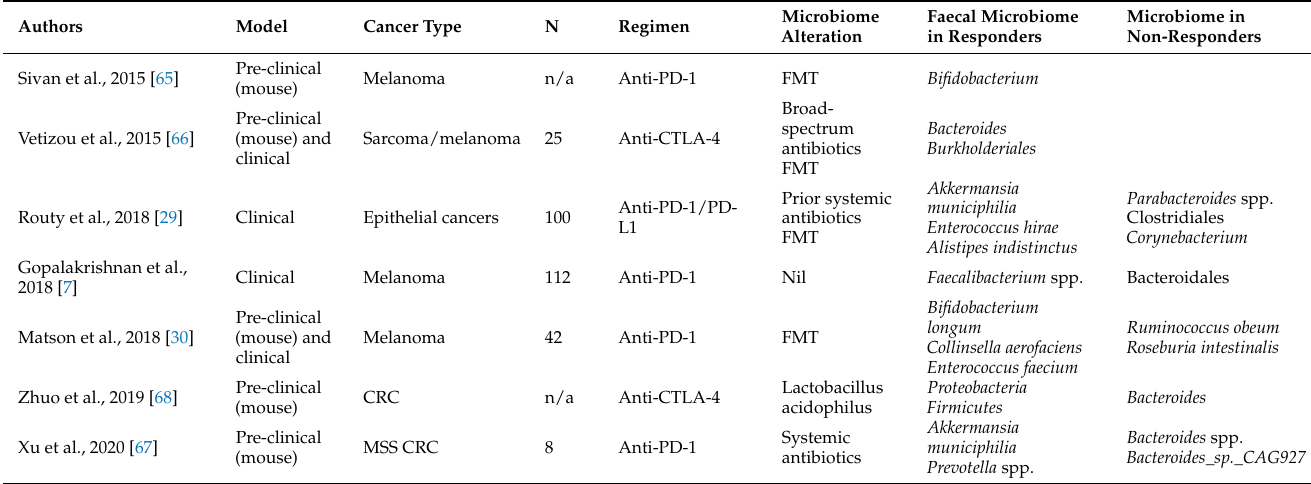
Table 3. Studies investigating the gut microbiome and immunotherapy